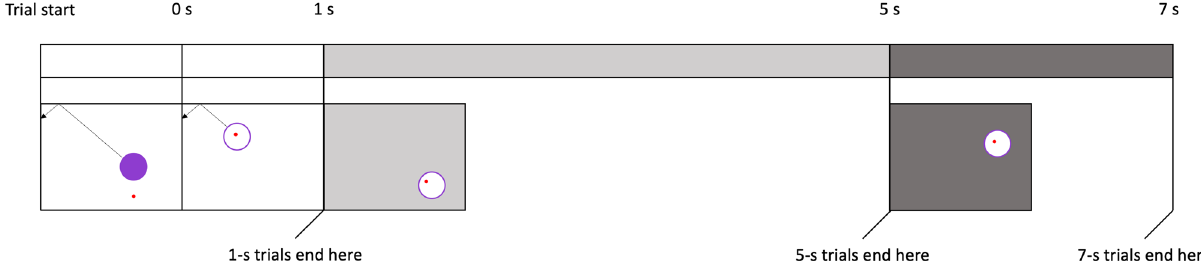
Figure 1. Schematic trial progression. Dotted line and arrow show an example trajectory of the target (not present on actual trials). The tracking duration started when the cursor entered the target and lasted 1, 5, or 7 s. If the target was tracked for the entire duration, the monkey was rewarded; if they lost contact with the target, the trial ended without reward. In the unsignalled condition, the background colour remained white throughout the trial. In the signalled condition (shown here), the background colour changed to light grey after 1 s and to dark grey after 5 s. For an animated example, see Supplementary Fig. S1.